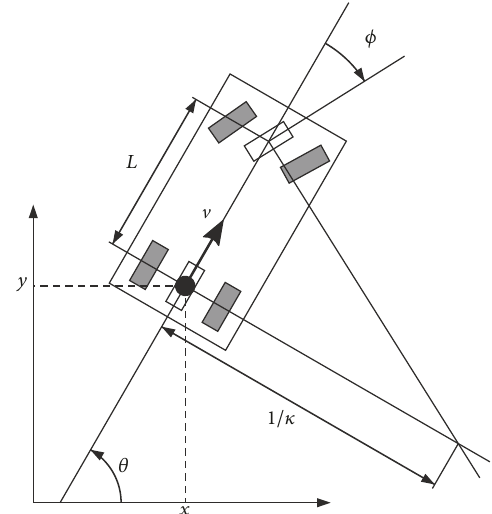
Figure 1: Kinematic model of a